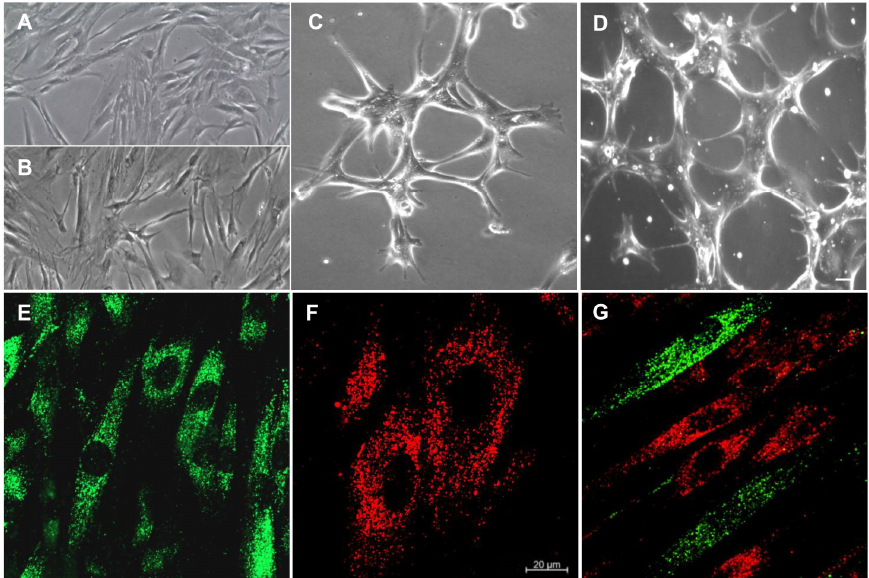
Figure 2. Morphological analyses. ( A ) Undi ff erentiated hPDLSCs observed at light microscopy. ( B ) E-hPDLSCs observed at light microscopy. ( C , D ) E-hPDLSCs cultured on Cultrex ® observed at light microscopy. ( E ) Undi ff erentiated hPDLSCs evaluated under CLSM (PKH67, green fluorescence). ( F ) E-hPDLSCs evaluated under at CLSM (PKH26, red fluorescence). ( G ) Coculture of hPDLSCs and E-hPDLSCs. Scale bar: 20 µ m. Magnification: 10 × ( A – D ). Magnification: 20 × ( E – G